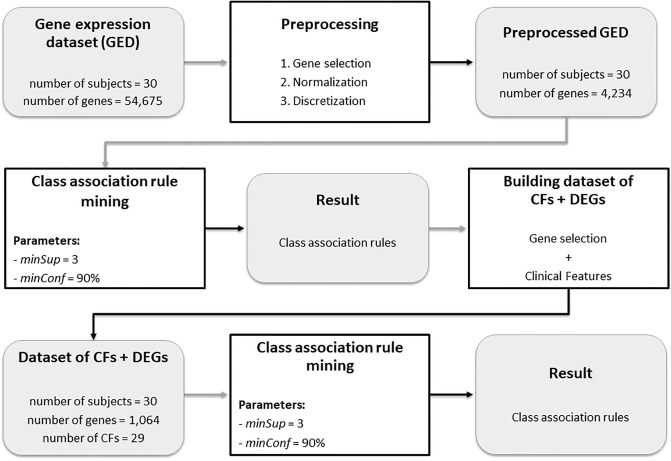
Flowchart that summarizes the process of class association rule mining from the dataset containing both clinical features (CFs) and differentially expressed genes (DEGs).